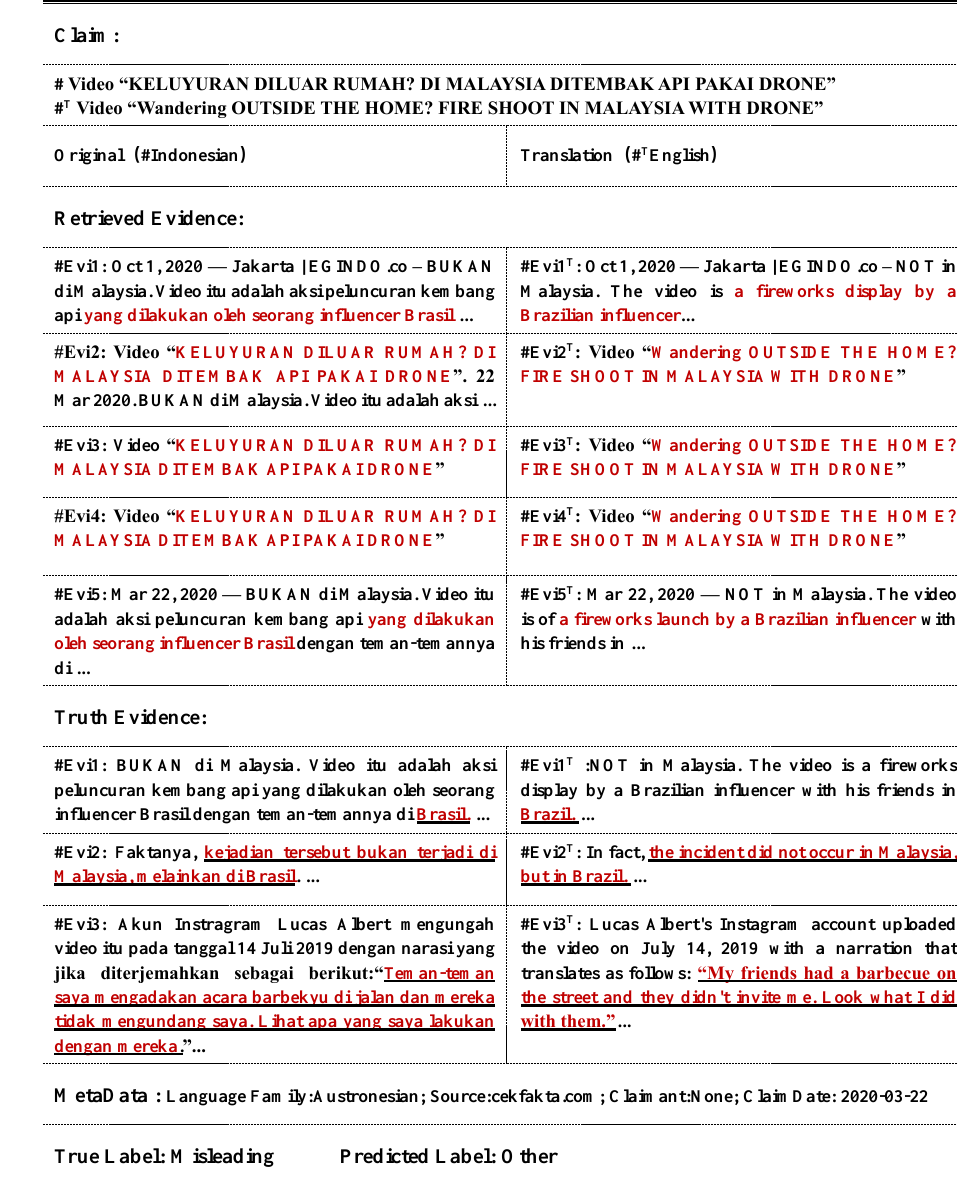
Figure 3. A typical error analysis example in which the true label is misleading, while the predicted label is the other. The claim and retrieved evidence, which is highlighted in red font, come from the training dataset, and part of the truth evidence, which is marked with red font and is underlined, are manually searched from the evidence source website. For reference, translations are also shown. In addition, the metadata are also listed for